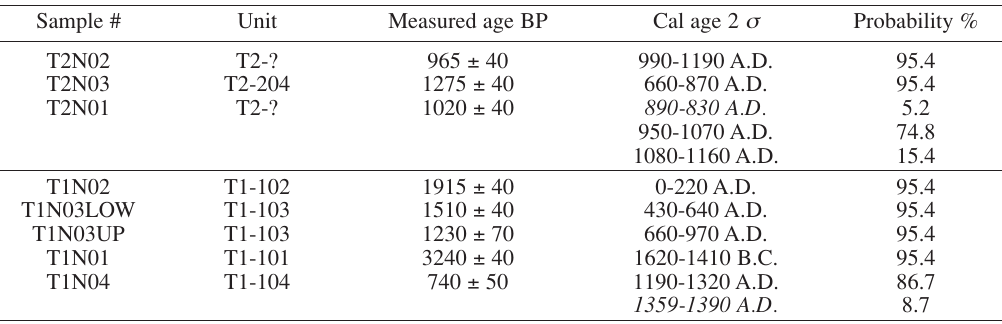
Table I. Measured and dendrochronologically corrected ages of samples collected in the trenches 1 and 2. Measured ages have been corrected for C 12 /C 13 in the laboratory and for C 12 /C 14 by using the calibration pro- gram Oxcal v3.5 (Bronk Ramsey, 2000). For each sample a probability density is obtained. We report the 2 (cid:109) interval with the associated probabilities. For our study we took under consideration only the age intervals with probability above